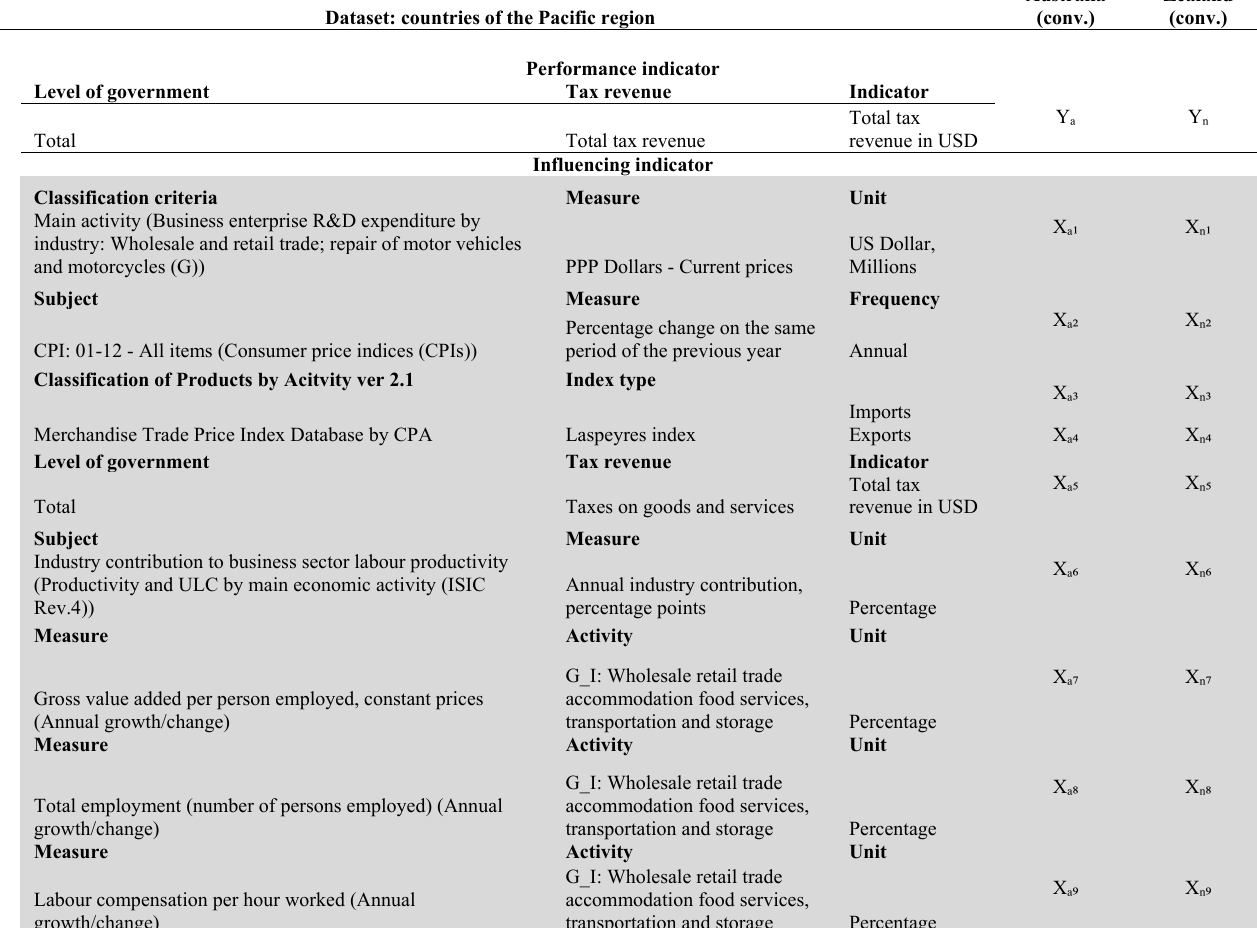
New Australia Zealand ( с onv.) ( с onv.)